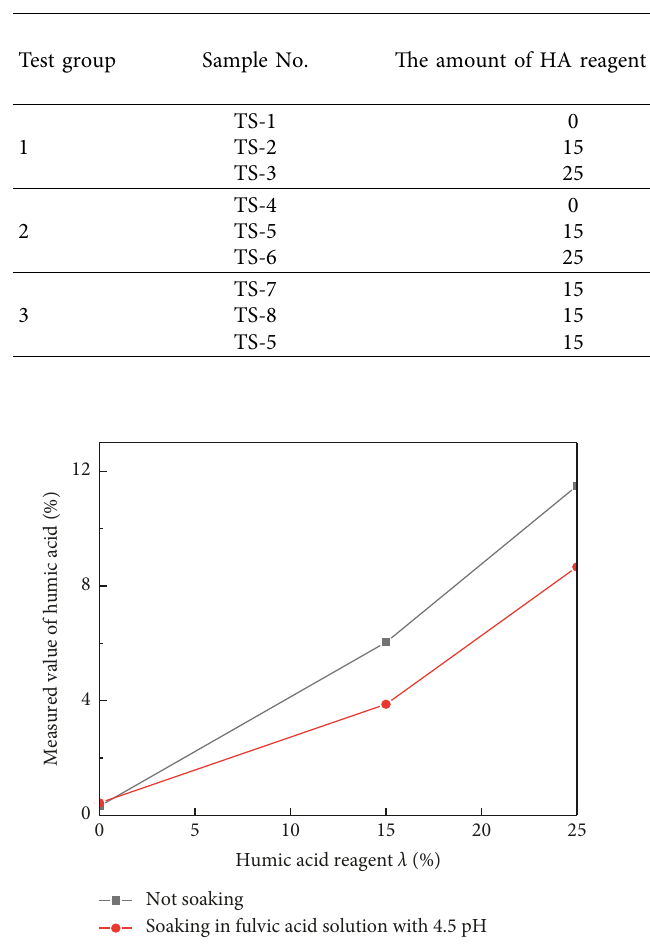
Figure 5: Relationship curve between the measured value of HA content and the amount of HA reagent in the samples.